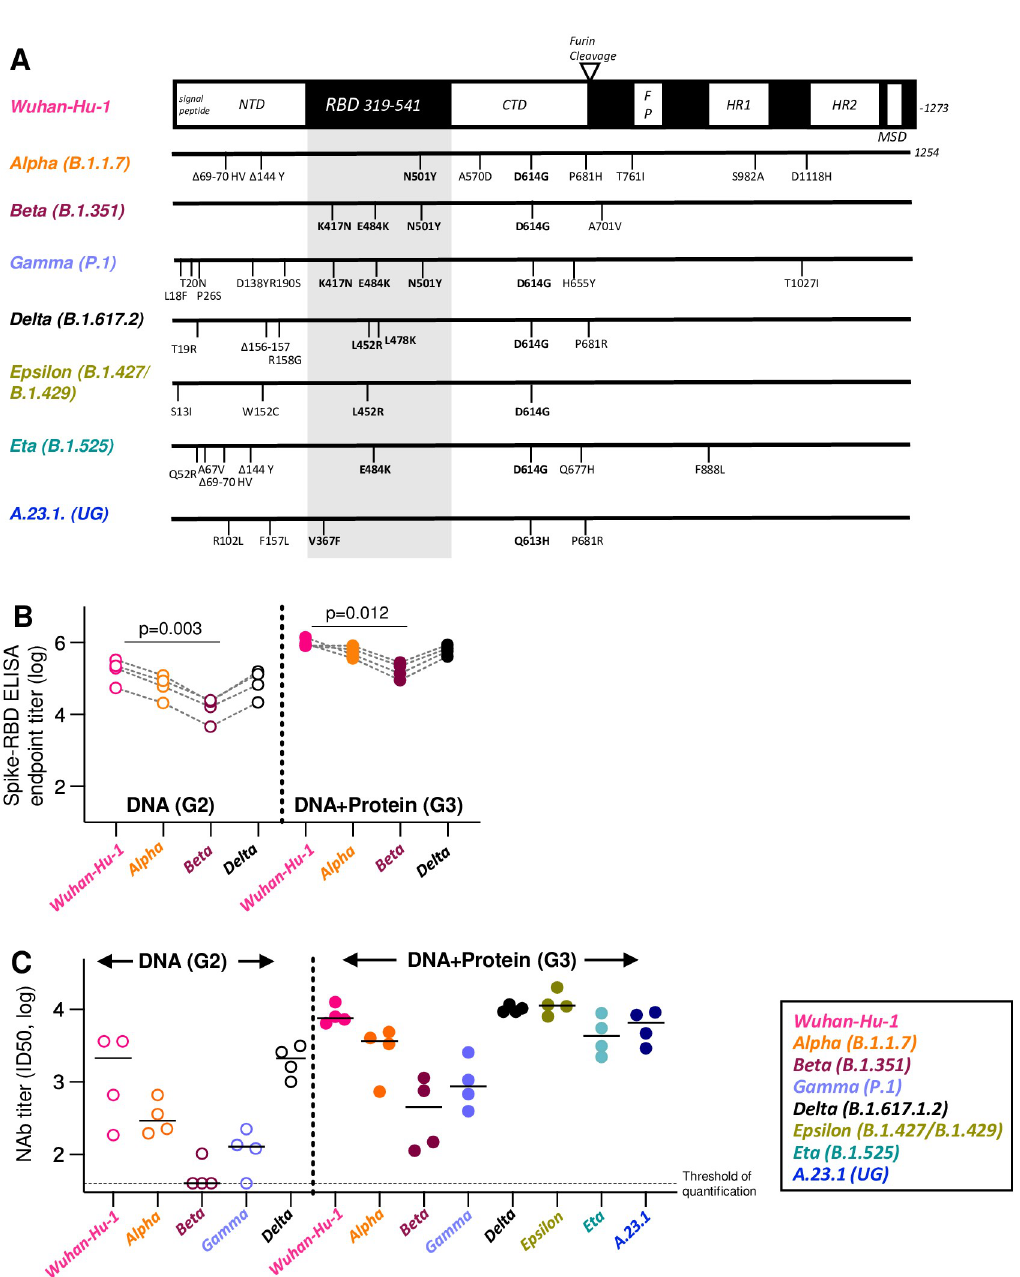
Fig 3. Induction of cross-reactive binding and neutralizing antibodies. ( A ) Schematic representation of a panel of Spike variant proteins used in pseudotype virus neutralization assay. RBD is indicated in the grey shaded area. All Spike variants, have the D614G change. ( B ) Cross-binding to Spike-RBD of sera collected 2 weeks after the last vaccination of the group that received DNA only (G2; left panel; N = 4) compared to DNA+Protein group (G3; right panel; N = 4) are shown for Wuhan-Hu-1, Alpha, Beta and Delta Spike-RBD. P values are from ANOVA, Friedman test. ( C ) Cross-neutralization of sera collected 2 weeks after the last vaccination (same sera as in panel B) of the group that received DNA only (G2; left panel) compared to DNA+Protein group (G3; right panel) are shown for Wuhan-Hu-1 Spike and the indicated variant Spike proteins. Reciprocal pseudotype NAb ID50 titers (log) are plotted for individual animals. The NAb ID50 threshold of quantification (0.5 log) and the threshold of detection (0.1 log) in this assay are indicated. Median values are